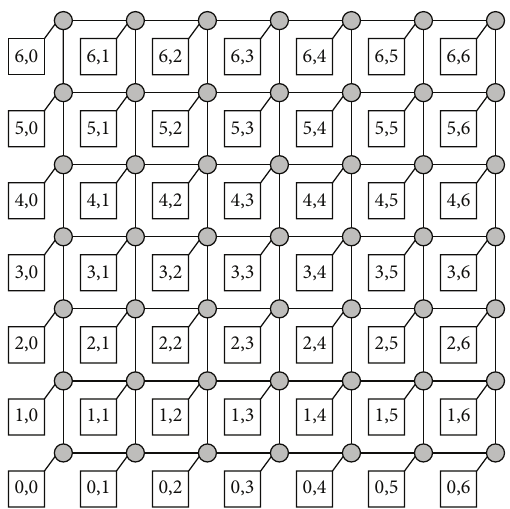
Figure 2: An entry space with 49 allocation slots (7 × 7).